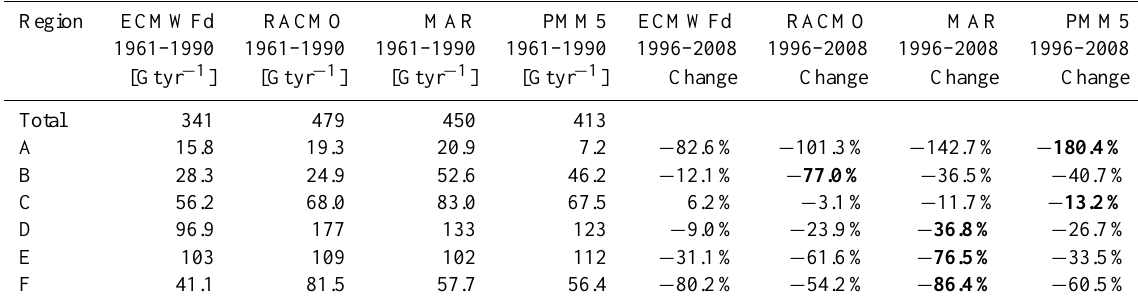
Table 3. Annual regional SMB (common mask); the mean over 1961–1990 period and the change over 1996–2008 period. Largest change highlighted in